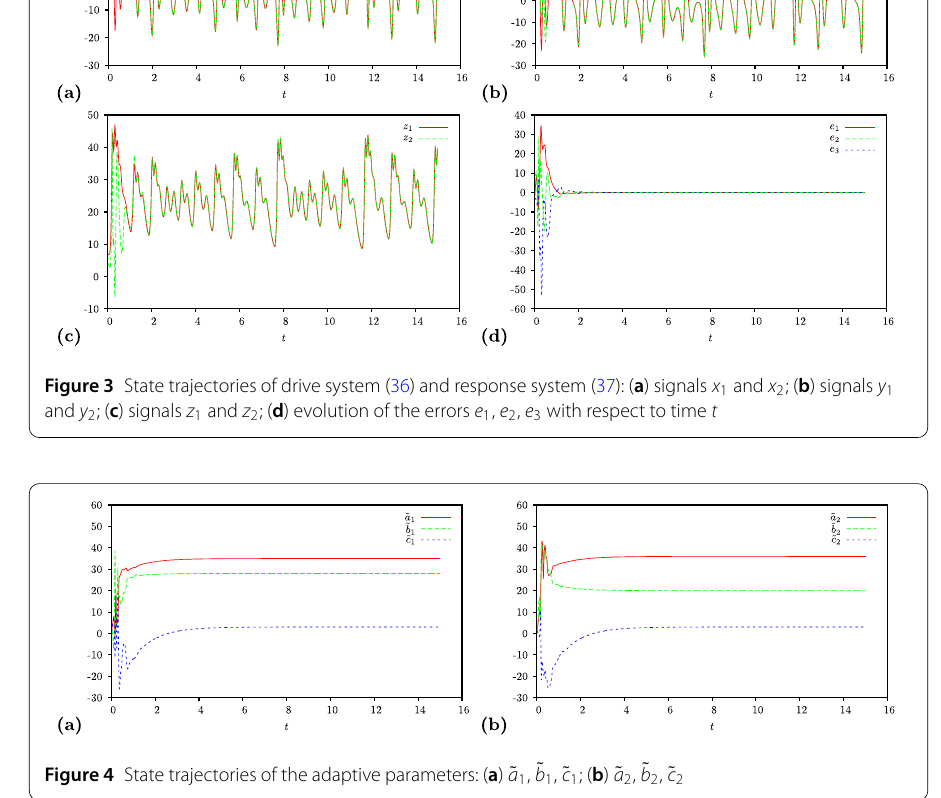
of different unknown fractional-order chaotic systems. Simulation results validate the effi- ciency and performance of the proposed modified adaptive sliding-mode synchronisation strategy. For future study, designing a modified adaptive sliding-mode controller to realise chaos synchronisation in drive-response dynamical networks is worth